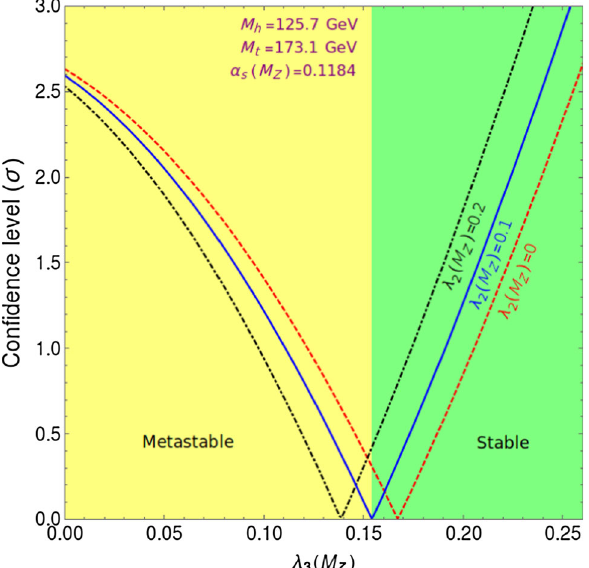
Fig. 6 Dependence of confidence level at which the EW vacuum sta- bility is excluded (one-sided) or allowed on λ 3 ( M Z ) and λ 2 ( M Z ) in ITM. Regions of absolute stability (green) and metastability (yellow) of EW vacuum are shown for λ 2 ( M Z ) = 0 . 1